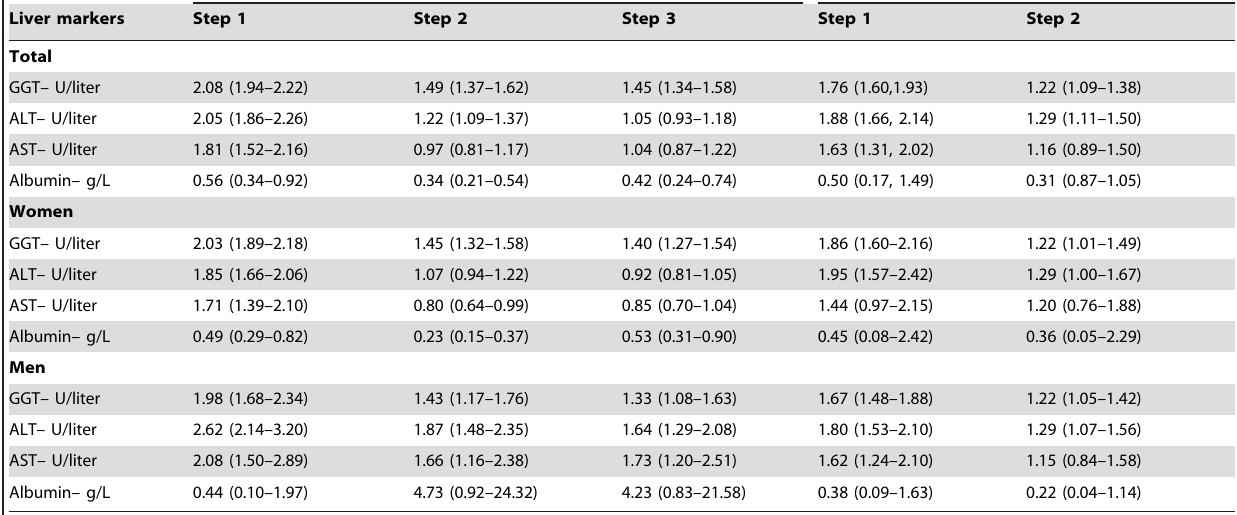
PREVEND cohort study OR (95% CI) per log2 unit